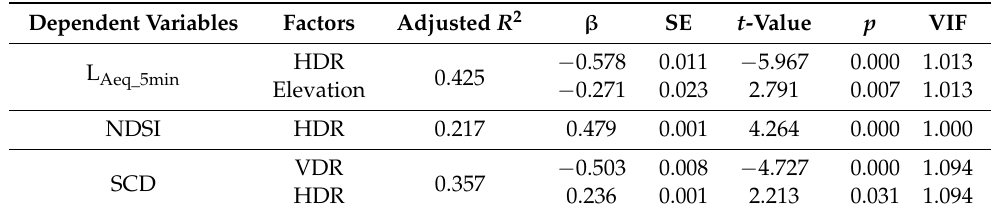
Table 5. Results of multiple linear regression analyses of spatial indicators and soundscape evaluation